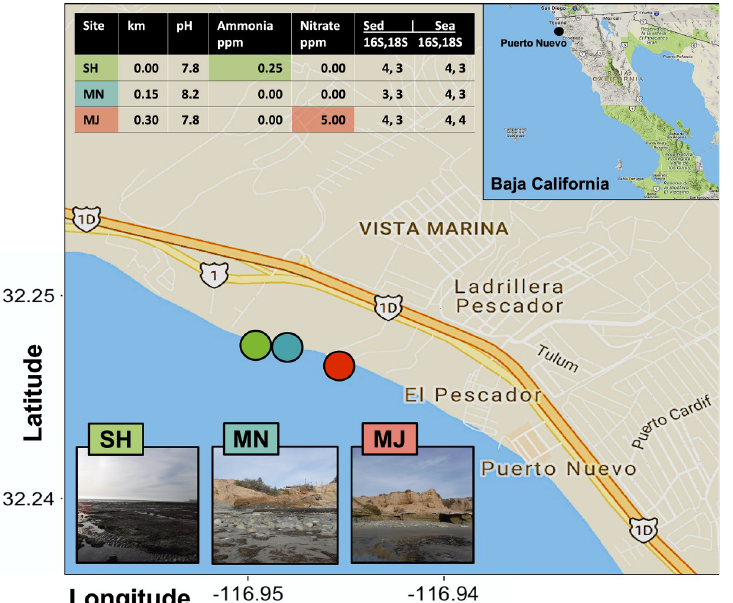
Fig 1. Location and metadata information of sampling sites. The three sampling sites are denoted in lime green (SH or sheltered), cyan (MN or Minor Outlet) and red (MJ or Major Outlet) circles. Sequenced samples based on seawater or sediment are displayed in the right-hand table columns for a total sequence output of 42 out of 48 samples submitted. The inset illustrates the approximate sampling location within Baja California, as denoted with a black circle. Chemical differences unique to sites are highlighted using colored boxes in the upper inset table and km refers to the distance in kilometers that MN and MJ are relative to SH.